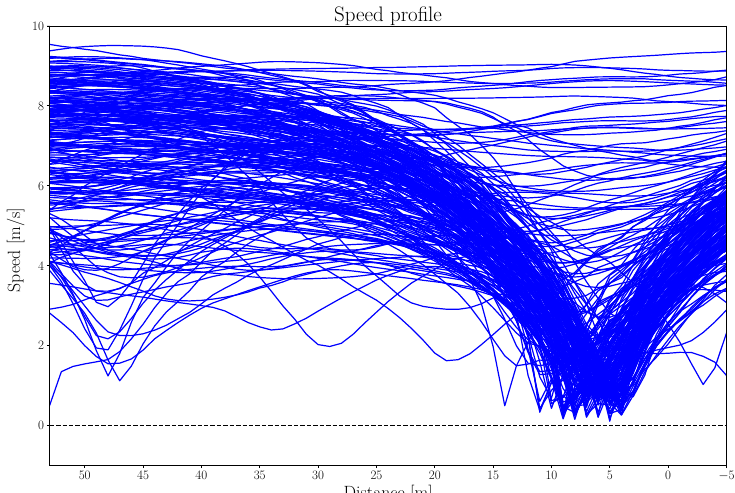
Figure 9. Speed profiles of all drivers when approaching and crossing blind intersections (232 inter- section crossings by 18 drivers).